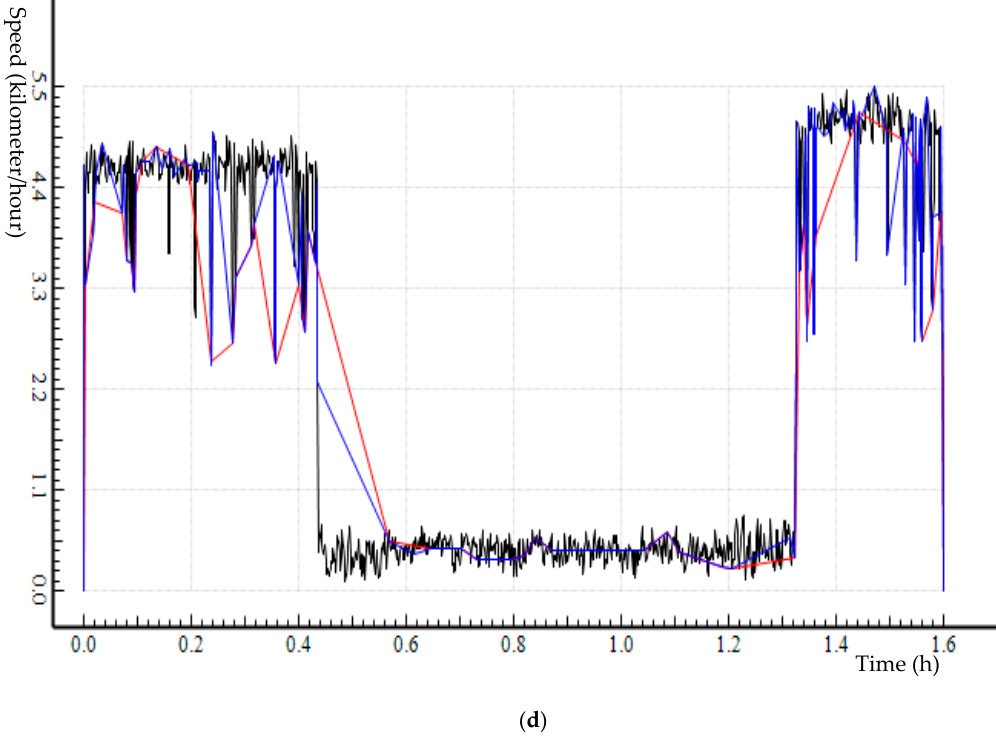
Figure 9. Speed–time graphs of the original Trajectory 1 data and the simplified trajectory data based on DP and EDP algorithms with a distance threshold of: 1-m ( a ); 5-m ( b ); 10-m ( c ); and 25-m ( d ).